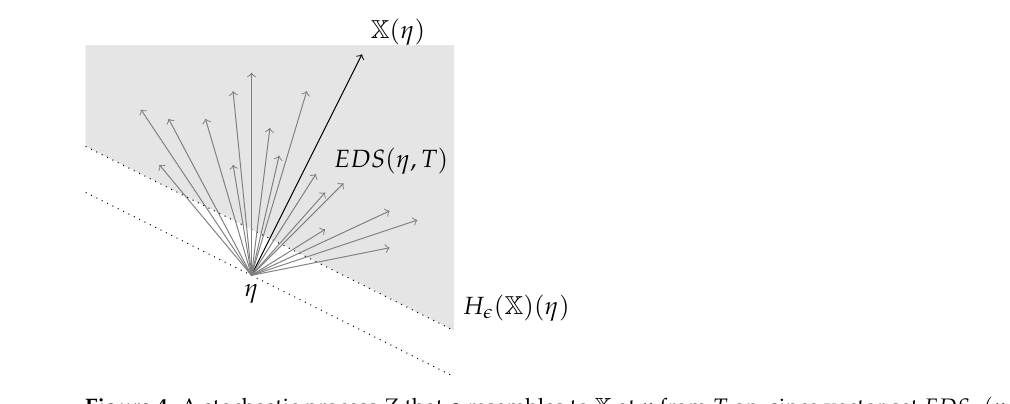
Figure 4. A stochastic process Z that (cid:101) -resembles to X at η from T on, since vector set EDS Z ( η , T ) of all expected directions of Z at η after time T belongs to H (cid:101) ( X )( η )